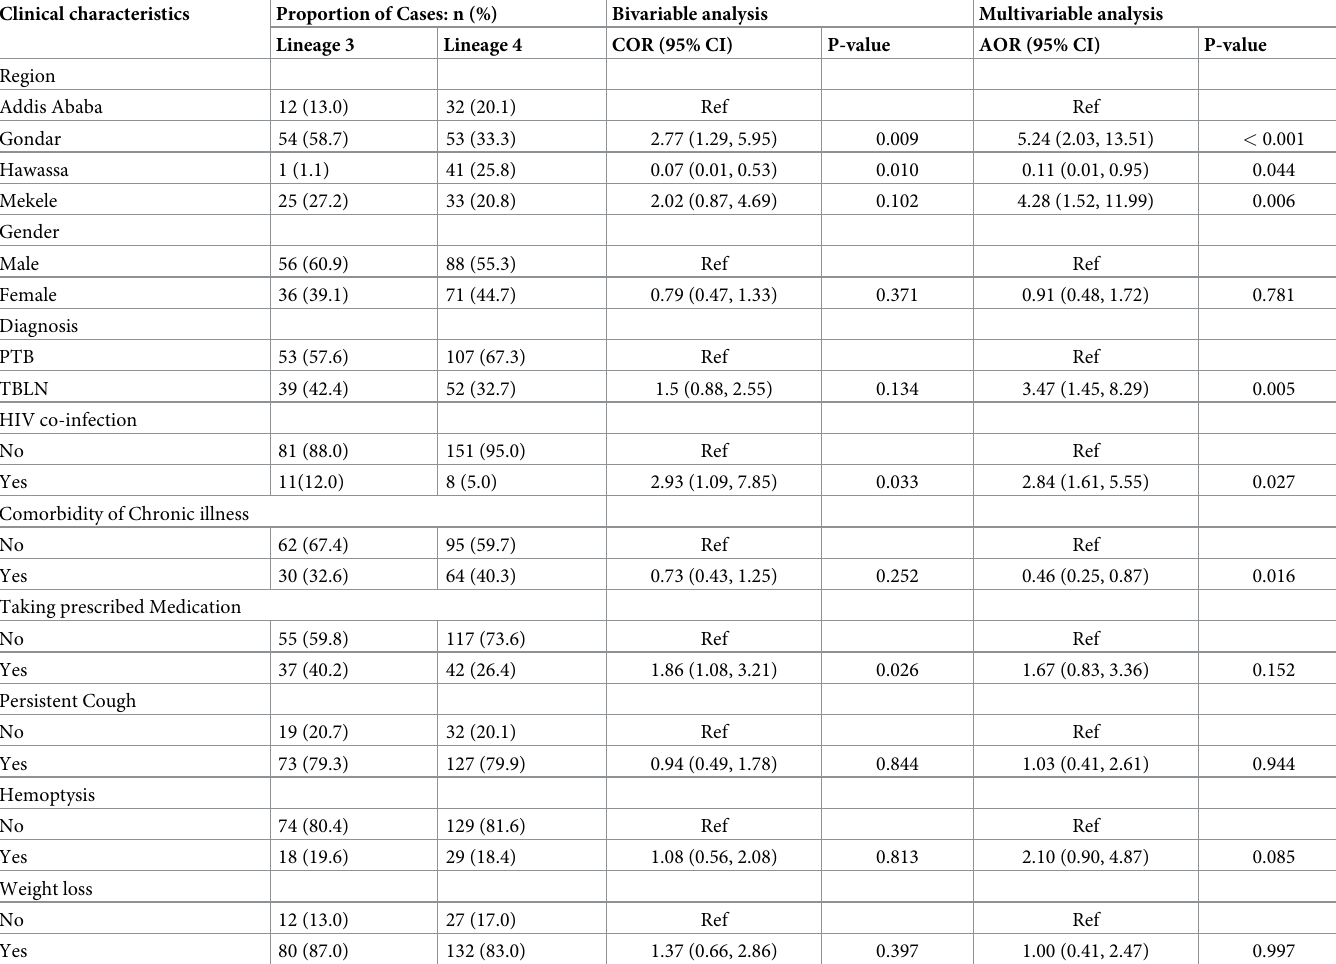
Table 5. Results of logistic regression analysis exploring associations between clinical characteristics and active TB disease caused by L3 versus L4, the two most dominant Mycobacterium tuberculosis lineages identified in the study. Clinical